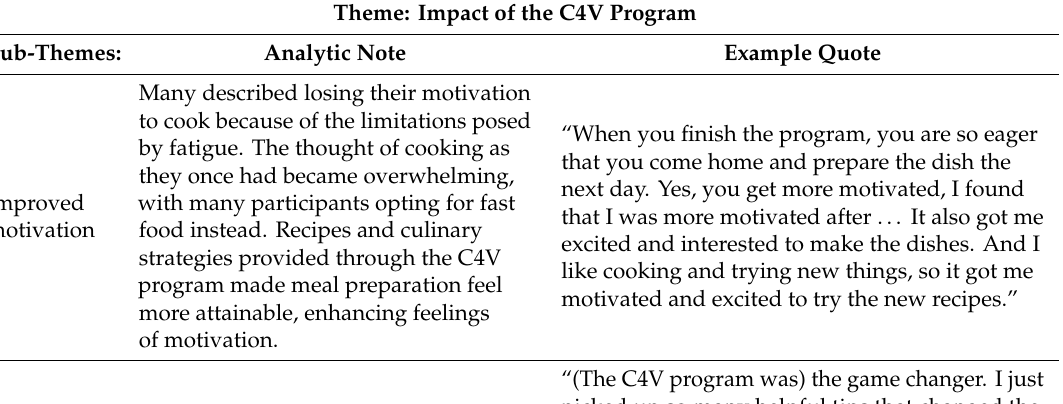
Table 5. Qualitative table for clinical